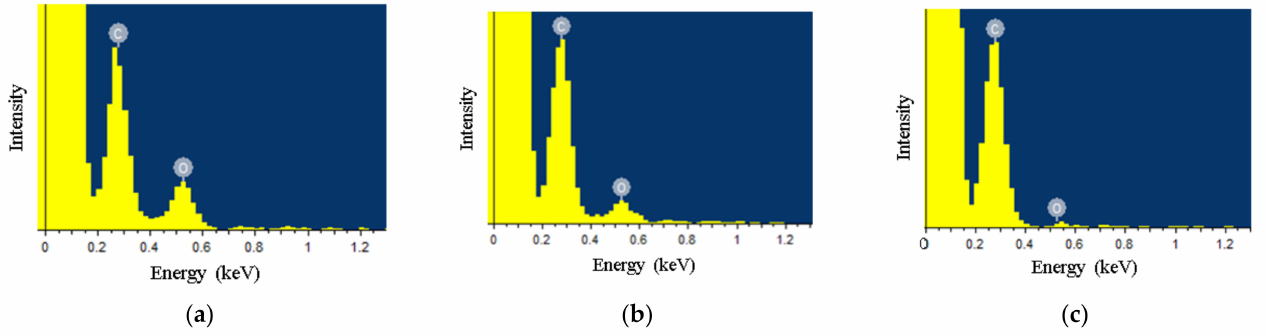
Figure 5. EDS spectrum for MOG ( a )—without reduction, ( b )—thermal reduction, ( c )—laser